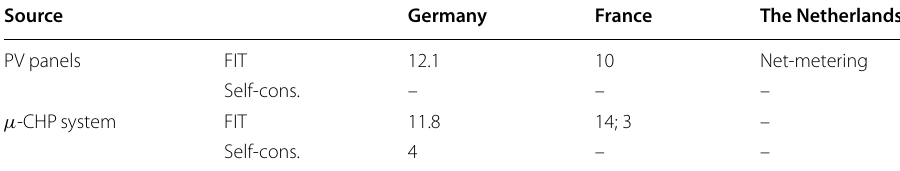
Feed-in tariffs (FITs) and compensation for self-consumption for 2018. Values are in cent/kWh